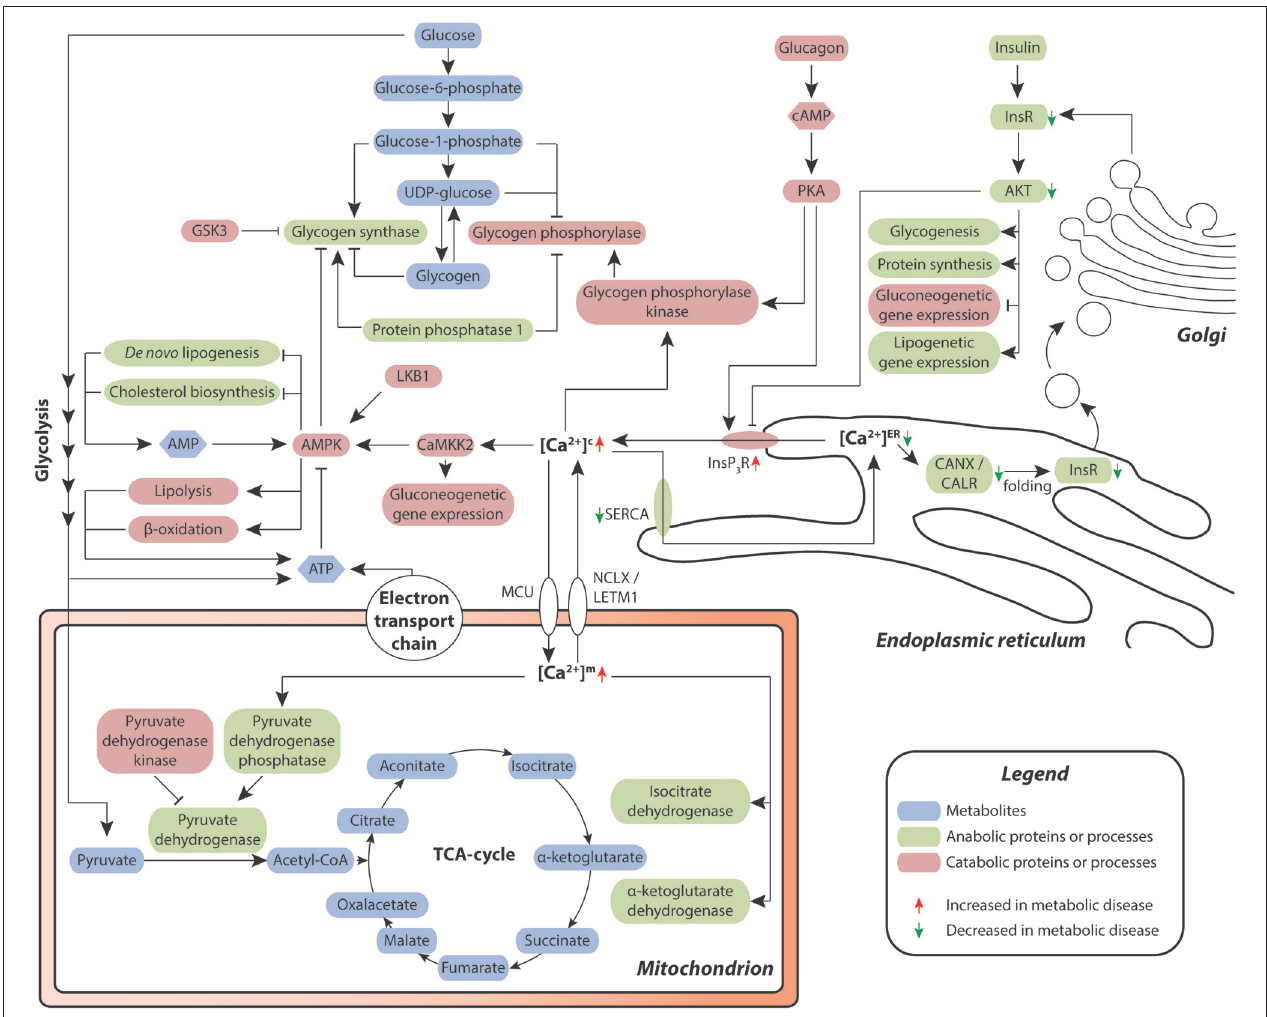
FIGURE 3 | Hepatic calcium signaling in metabolic disease. Cytosolic calcium is of central importance for the orchestration of metabolic control in the liver. Chronic redistribution of calcium from the ER into the cytosol results in a diminished capacity of calcium-dependent folding in the ER, resulting in ER stress and unfolded protein response. Signaling via the Insulin-InsR-AKT axis contributes to a decrease of calcium efflux from the ER. As a result, less correctly folded insulin receptor (InsR) is produced, leading to reduced insulin signaling and reduced AKT-mediated negative feedback regulation of InsP 3 R-dependent calcium efflux from the ER, thus reinforcing insulin resistance. Metabolites are depicted in blue, proteins and secondary messengers involved in anabolic and catabolic processes are shown in green and red,